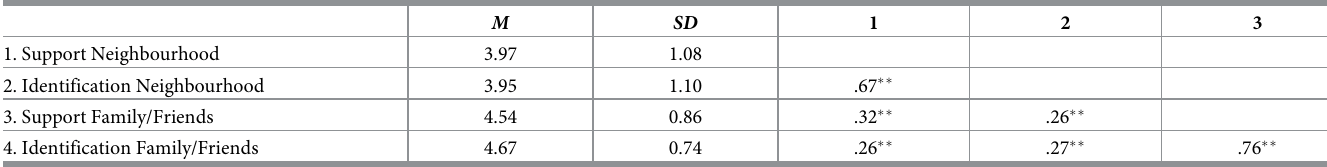
Table 2. Means, standard deviations, and correlations of four variables on social support from neighbourhood, identification with neighbourhood, social support from family/friends, identification with family/friends. M SD 1 2